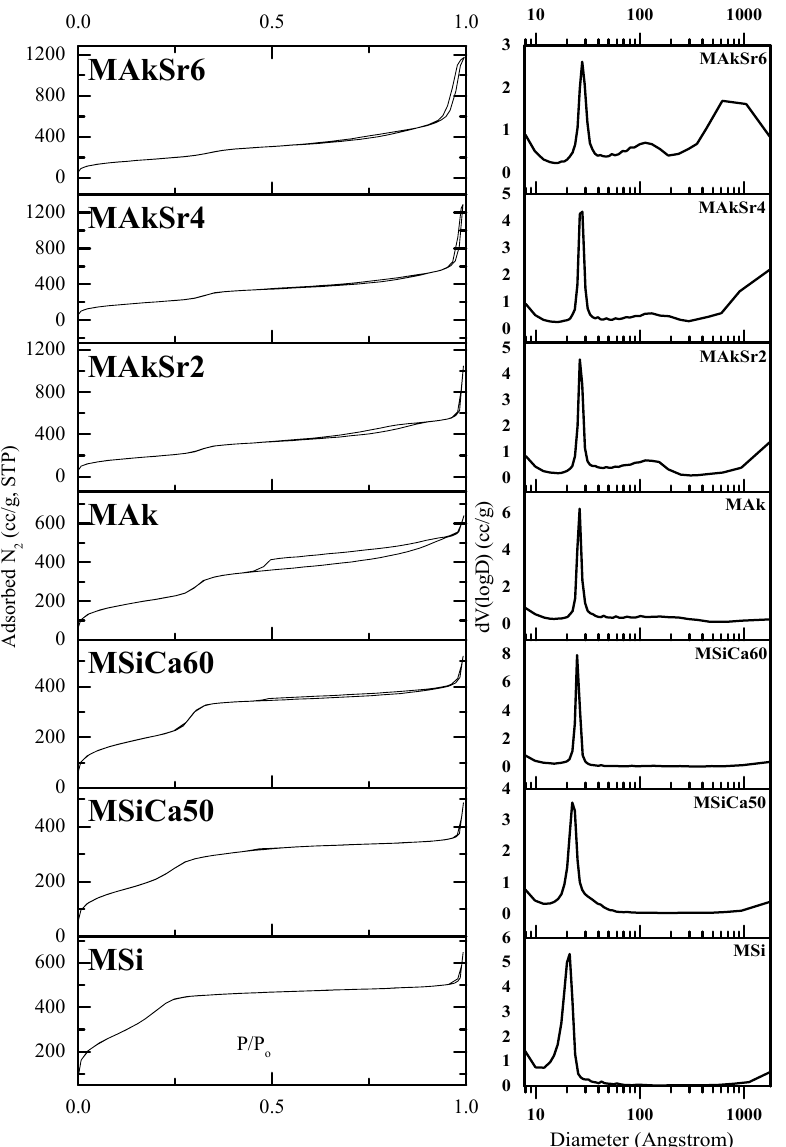
Figure 4. Nitrogen adsorption–desorption isotherms ( left ) of MSNs and their associated pore size distribution ( right ).